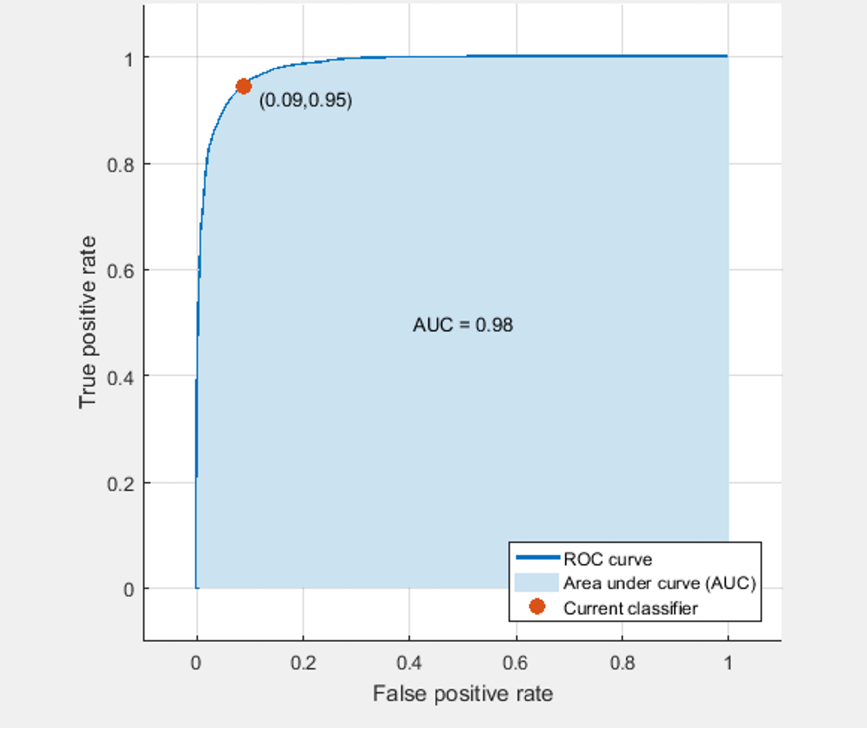
Figure 18. ROC of EMG measured from biceps brachii muscle bagged tree